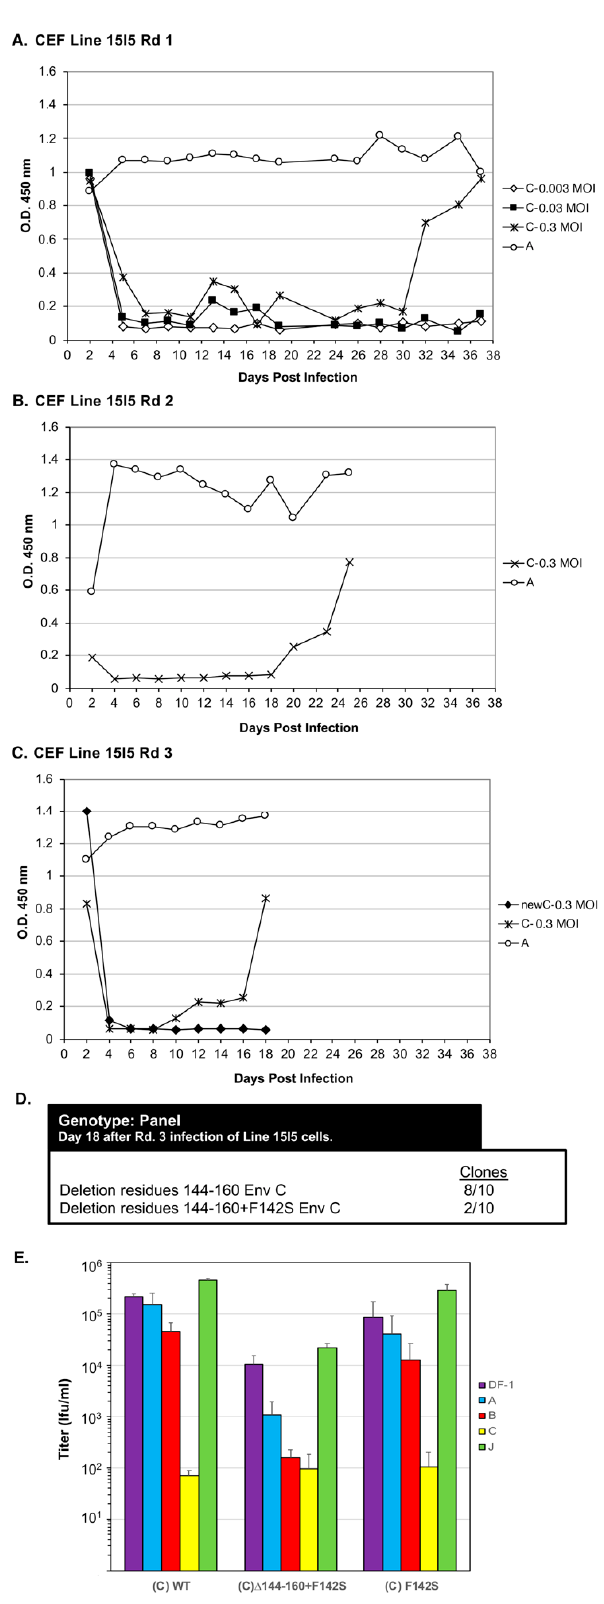
Figure 6. Genetic selection of RCASBP(C) mutants capable of efficient replication using Line 15I5 CEFs that lack a functional Tvc receptor. ( A ) Chicken embryo fibroblasts (CEFs) derived from Line 15I5 were infected with RCASBP(C) supernatant at 0.003, 0.03, and 0.3 M.O.I., or the positive control